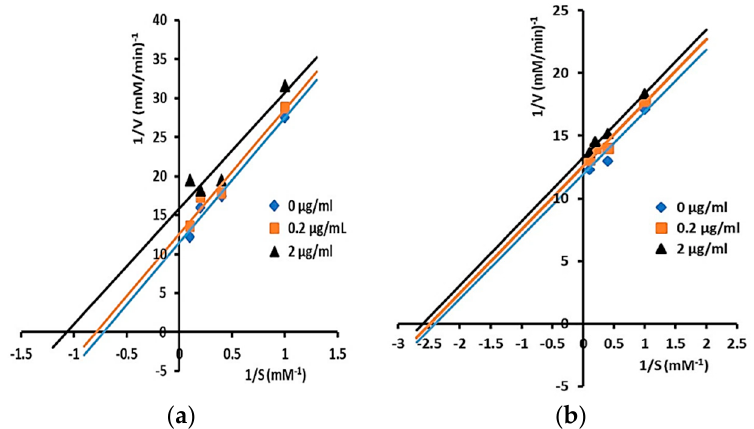
Figure 2. Lineweaver–Burk plots for kinetic analysis of α -glucosidase inhibition by isolated triterpenes: ( a ) compound 1 and; ( b ) compound 2 at varying concentrations (showing uncompetitive inhibition). The concentration of p-NPG was measured as a substrate in the absence or presence of inhibitors at different concentrations against α -glucosidase. All values are means ± standard errors ( n = 3).